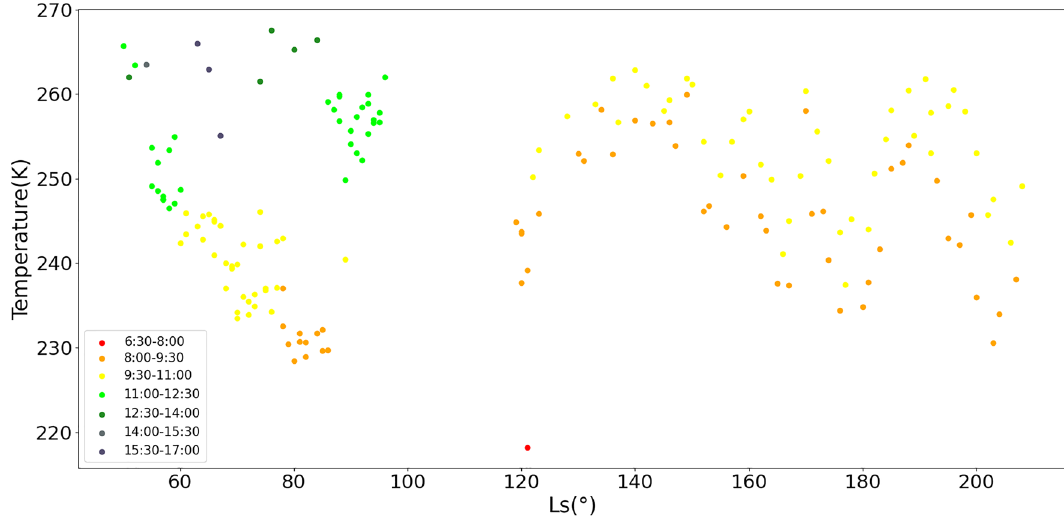
Figure 5. Temperature changes during mission time. Different colors correspond to different time